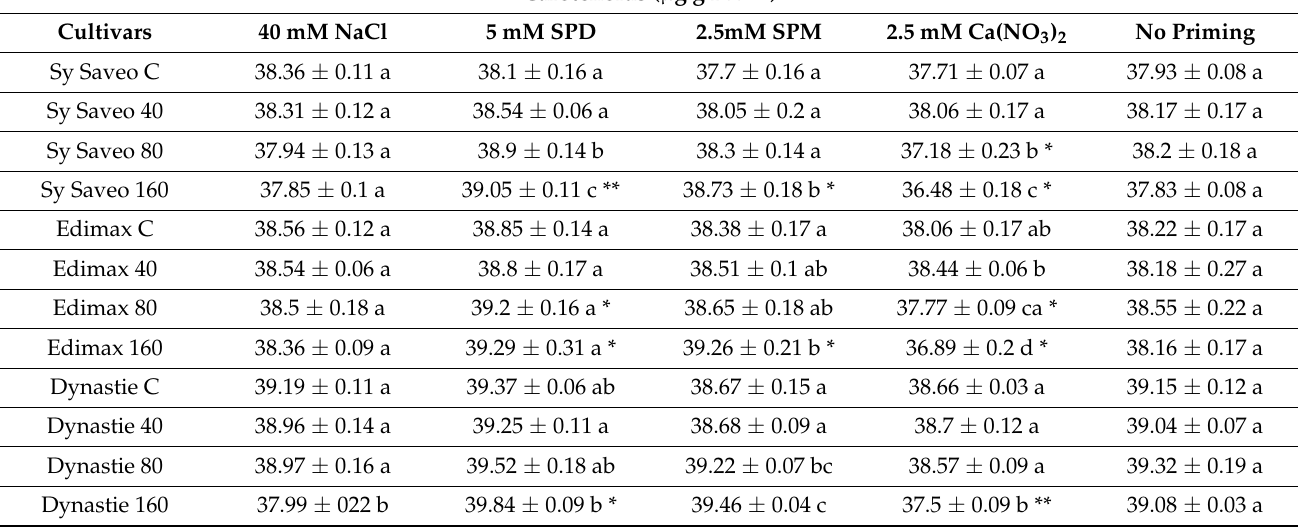
Table 6. Effect of different priming agents on total carotenoid content ( µ g g FW − 1 ) of rapeseed cultivars exposed to different saline conditions: 0 mM NaCl (C), 40 mM NaCl (40), 80 mM NaCl (80), 160 mM NaCl (160). Data are expressed as means ± SE ( n = 8). Mean values in the column marked by different letters are significantly different within the same group ( p ≤ 0.05; ANOVA and Tukey–Kramer test). Significant differences between groups are reported as * p < 0.05; ** p < 0.01; *** p <